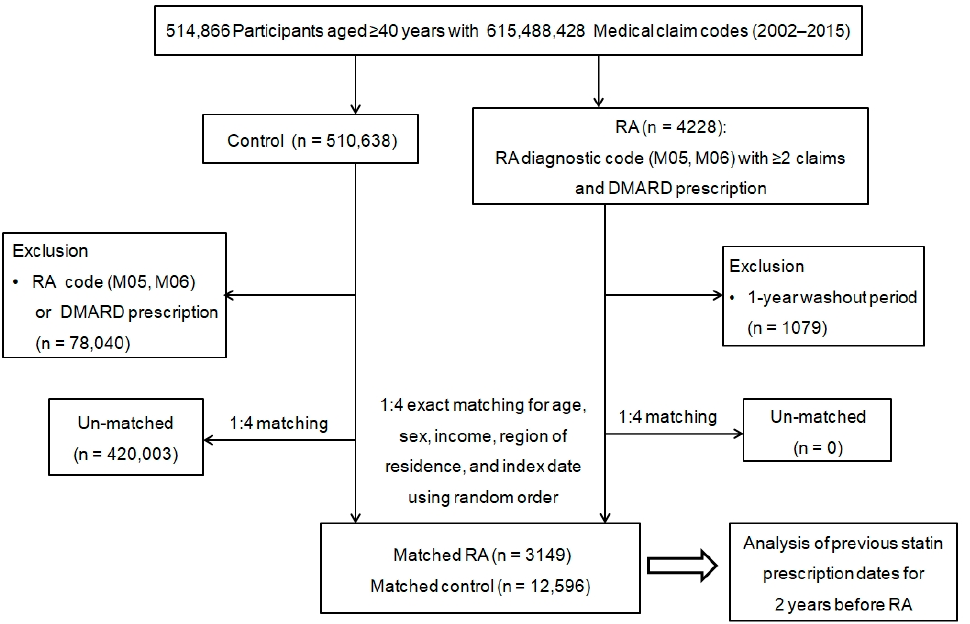
Figure 1. A schematic illustration of the participant selection process.